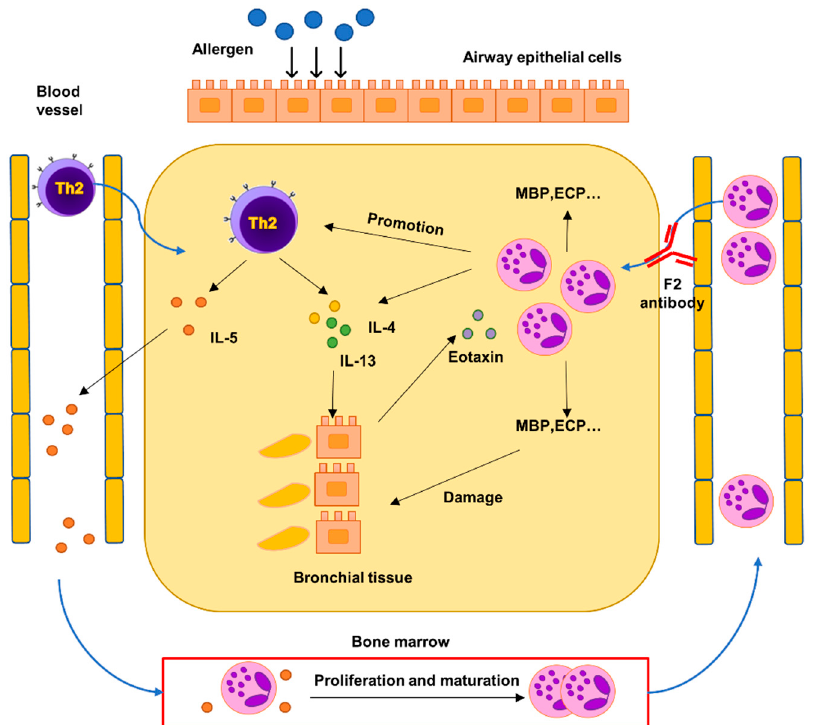
Figure 7. Possible mechanism underlying mAb F2-mediated suppression of the positive feedback loop in the asthma model. A hypothetical mechanism of the suppressive effects of F2 in the asthma model is shown in the figure. The initial exposure of the airway to environmental allergens can lead to the activation of pathogenic Th2 cells (upper left in purple). Th2 cells can then release Th2 cytokines, including IL-4, IL-5, and IL-13. IL-4 and IL-13 facilitate IgE class switching to activate local immune cells and cause damage to the bronchus. IL-5 is released into the peripheral blood and helps eosinophils to proliferate and mature in the bone marrow (bottom). The mature eosinophils translocate into the blood and infiltrate the sites of inflammation through the binding of sLex to P-selectin. The infiltrated eosinophils release tissue-damaging proteins such as MBP and cytokines, including IL-4 and IL-13. As a result, a positive feedback loop is formed, such that an increasing number of eosinophils are recruited to the lungs. However, when mAb F2 is administered (upper right), eosinophil infiltration is prevented in the lungs, which breaks the whole positive feedback loop to aggravate asthmatic symptoms, leading to a possible treatment for asthma.